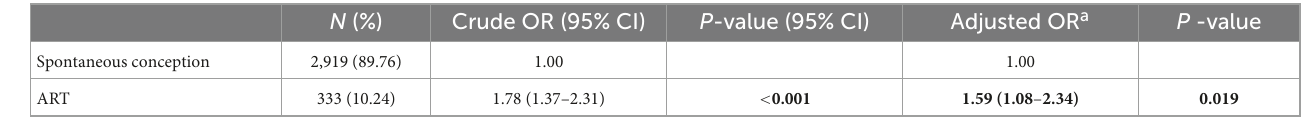
TABLE 2 Association of ART with maternal gestational diabetes